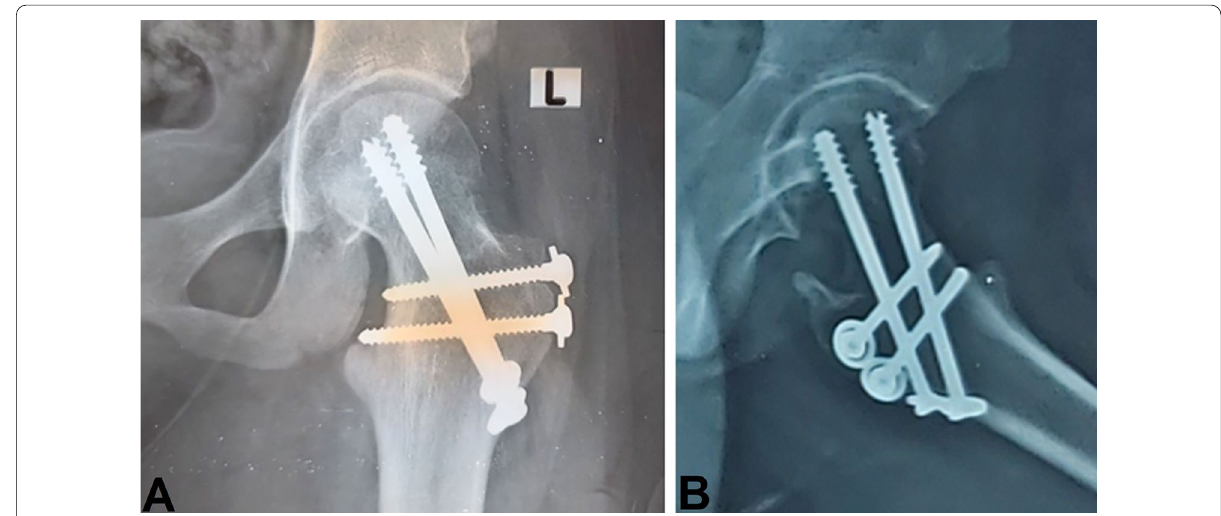
Fig. 7 Six‑year follow‑up X‑rays. A AP view. B Lateral view